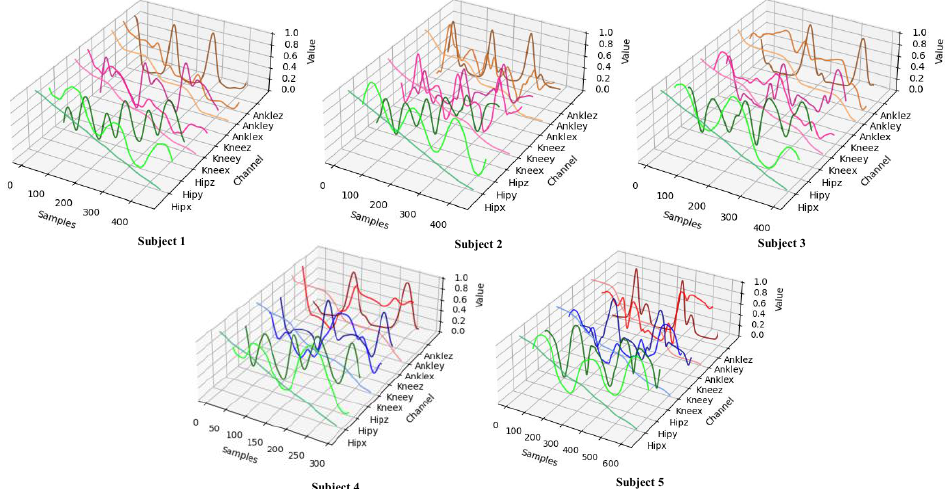
Figure 2. Real gait data stream captured by the motion